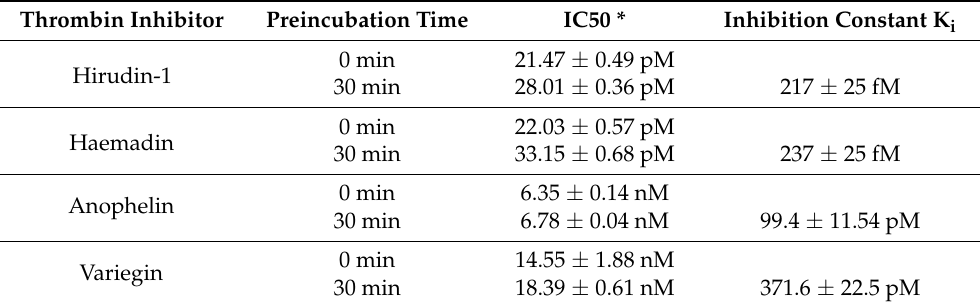
Table 1. Parameters of antithrombin activity of hirudin-1, haemadin, anophelin, and variegin. Thrombin